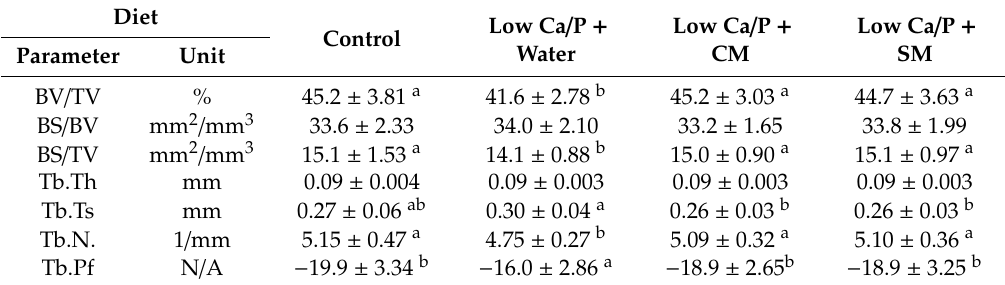
Table 2. Trabecular bone characteristics of rat femora from rats fed di ff erent diets.